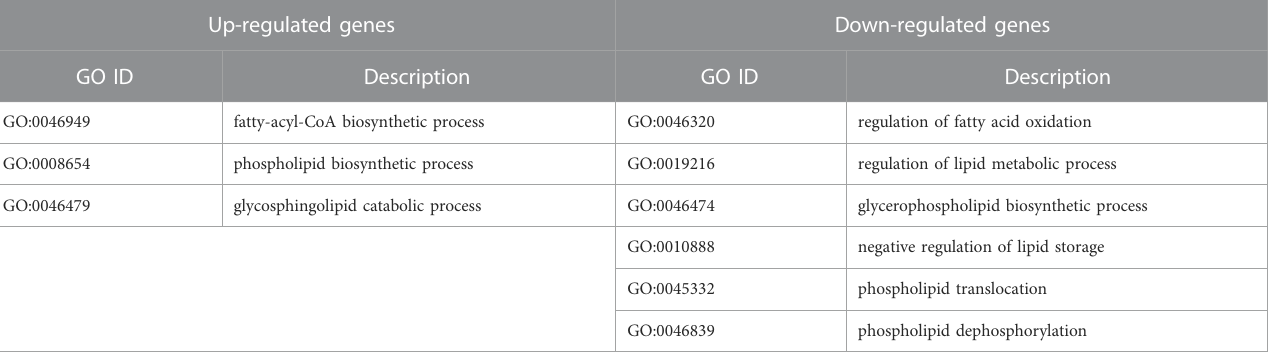
TABLE 2 Signi fi cantly changed ( p < 0.05) Gene Ontology biological processes after knockdown of IGFBP6 gene according to the proteomic analysis. Up-regulated genes GO